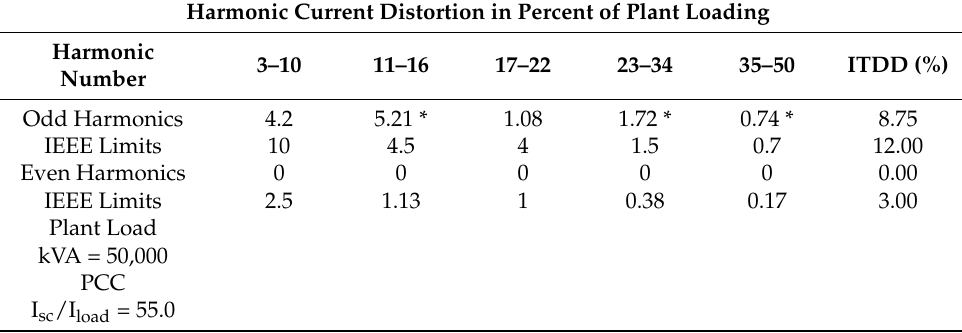
Table 6. ESA calculation results for IEEE Std. 519 current report without filter-1.